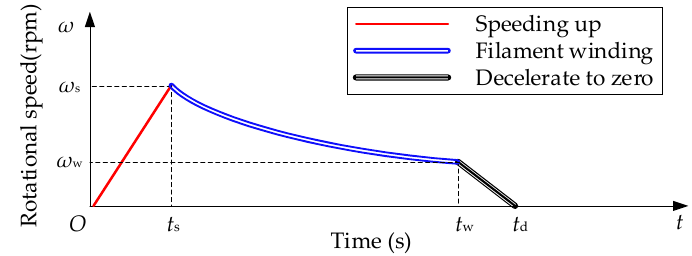
Figure 2. Diagram of the single cycle of winding task.